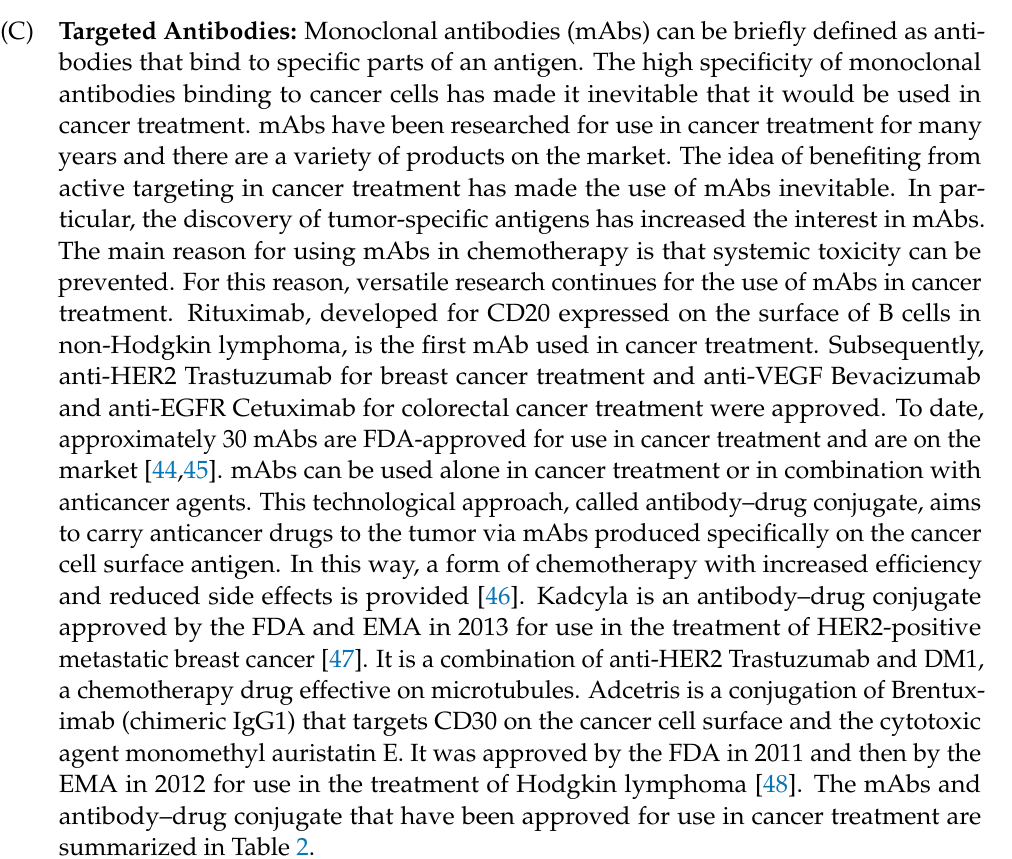
Figure 4. Adoptive cell therapy approaches.